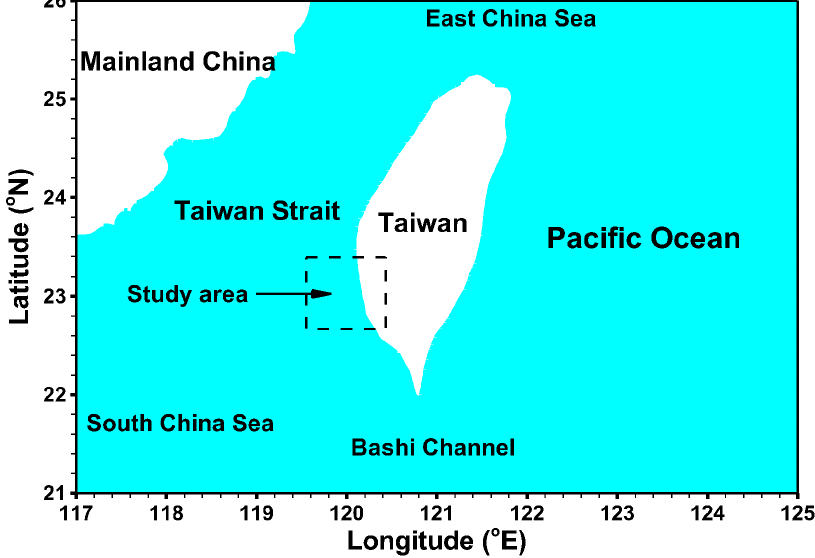
Figure 1. Map of study area shown with dashed line: the land, the coastal sea, and the Tsengwen River are included in the model domain. Cyan color and white color represent the ocean and land,